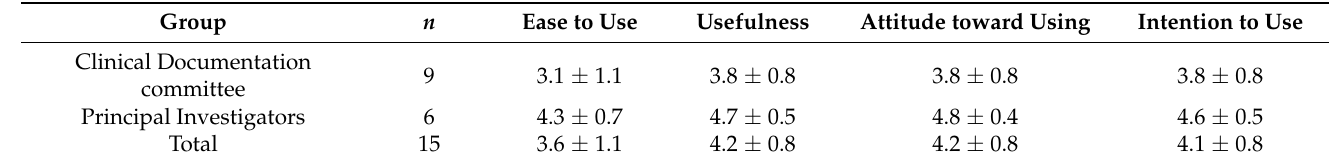
Table 2. Evaluation of end user perception through Technology Acceptance Model. Each domain provides the mean ± the standard deviation.